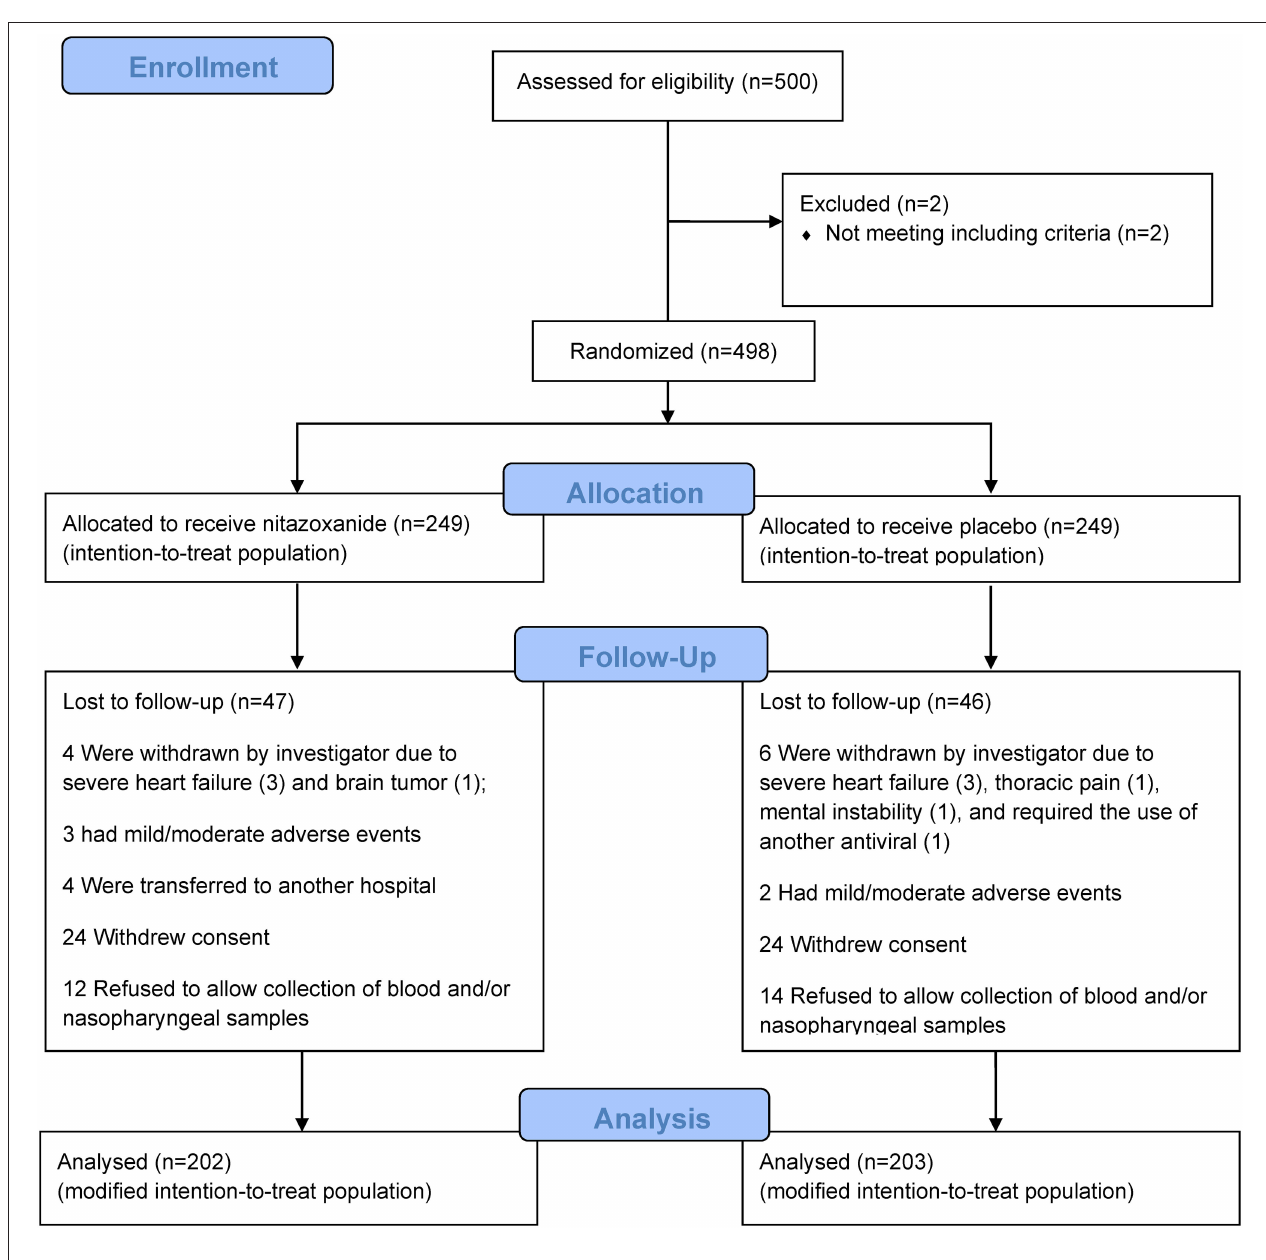
FIGURE 1 | Enrolment, randomization, follow-up, and treatment. Five hundred patients were assessed for eligibility at the study sites. Of these, 498 underwent randomization, 2 patients were excluded for not meeting the inclusion criteria. After randomization ( n = 249/group), patients were excluded because they were withdrawn by the investigator, had mild/moderate adverse events, were transferred to another hospital, withdrew consent at any time during the study, refused to allow collection of blood and/or nasopharyngeal samples. Therefore, the modified intention-to-treat population consisted of 202 patients in the nitazoxanide group and 203 patients in the placebo